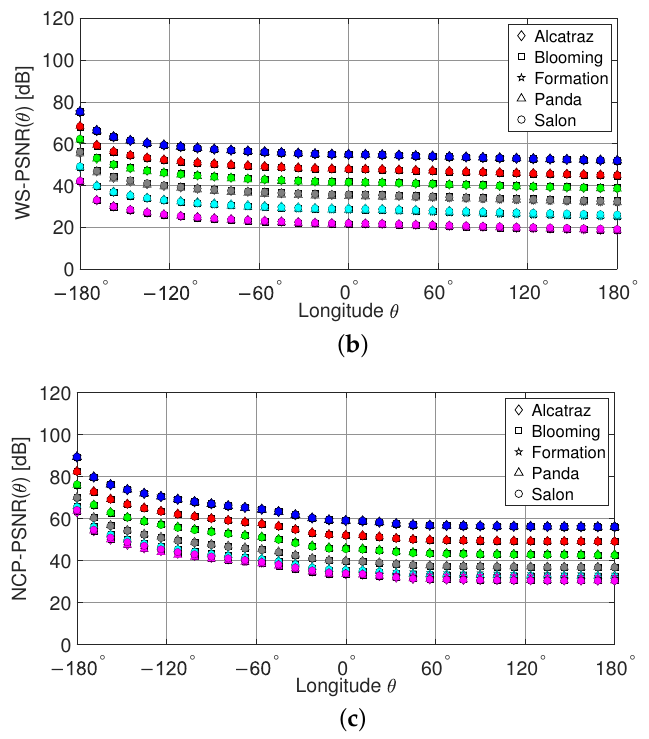
Figure 17. Fidelity of viewing direction based LSB data hiding in the longitude: ( a ) PSNR( θ ), ( b ) WS- PSNR( θ ), ( c ) NCP-PSNR( θ ).